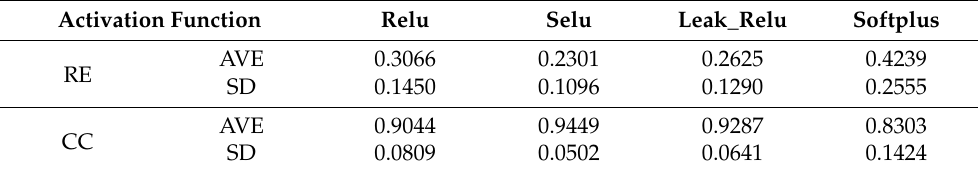
Table 3. The RE and CC of all samples in test set with different activation function.